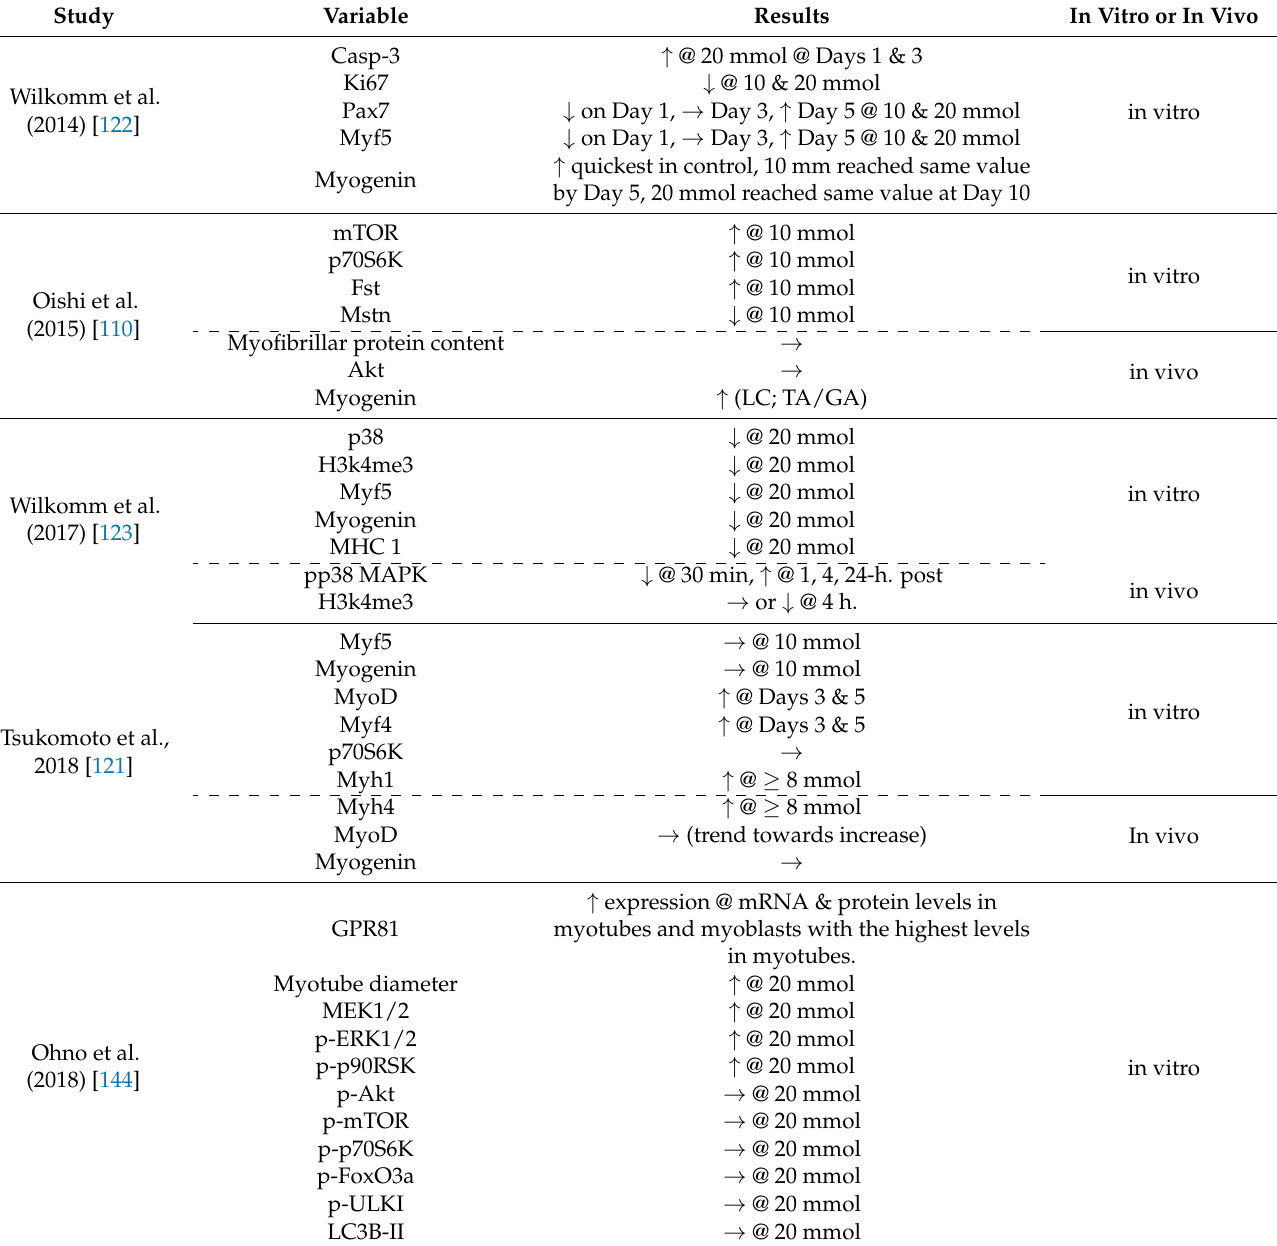
Table 1. Summary of in vitro and in vivo studies investigating anabolic effects of La −